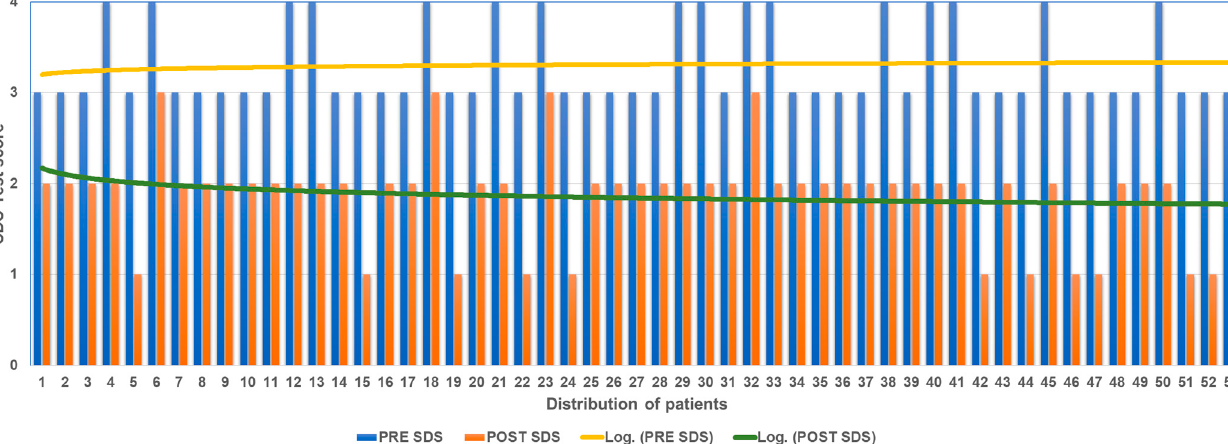
Figure 3. SDS score before and after ANM treatment. Of the 16 patients who at T0 with SDS had expressed pain at 4 (extremely severe), 4 at T2 expressed 3 (severe pain) and 12 at T2 expressed 2 (medium pain). Of the 37 patients who at T0 with SDS had expressed pain at 3 (severe pain), 26 at T2 expressed 2 (medium pain); 11 at T2 expressed 1 (medium pain).